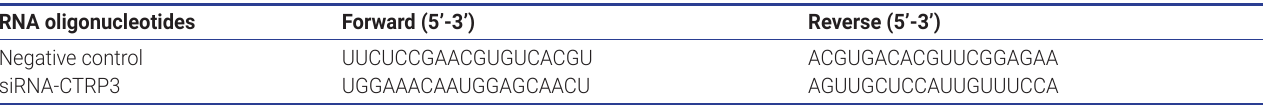
Table 2. Sequence of RNA